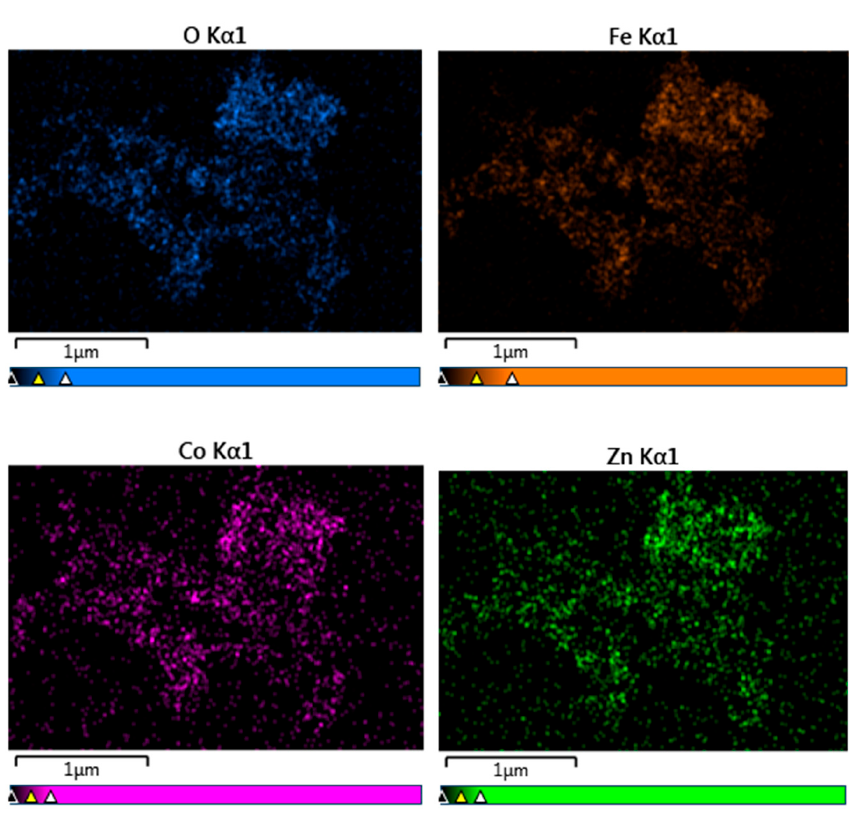
Figure 4. Elemental mapping of Co 0.4 Zn 0.6 Fe 2 O 4 nanoparticles.